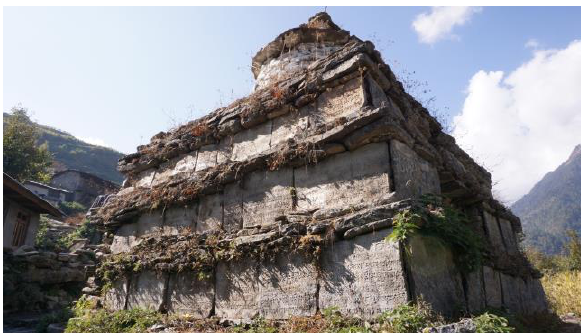
Figure 16. Detail of Mani Stone